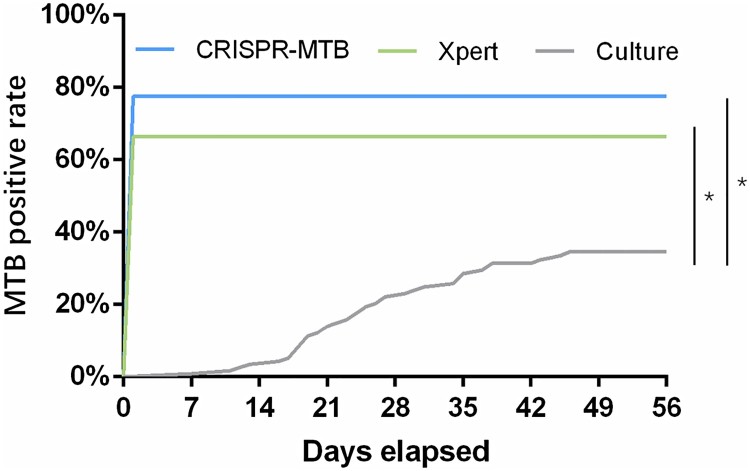
Kaplan–Meier curve of MTB positive rate by CRISPR-MTB, Xpert and culture. * Log-rank test, P < 0.0001.